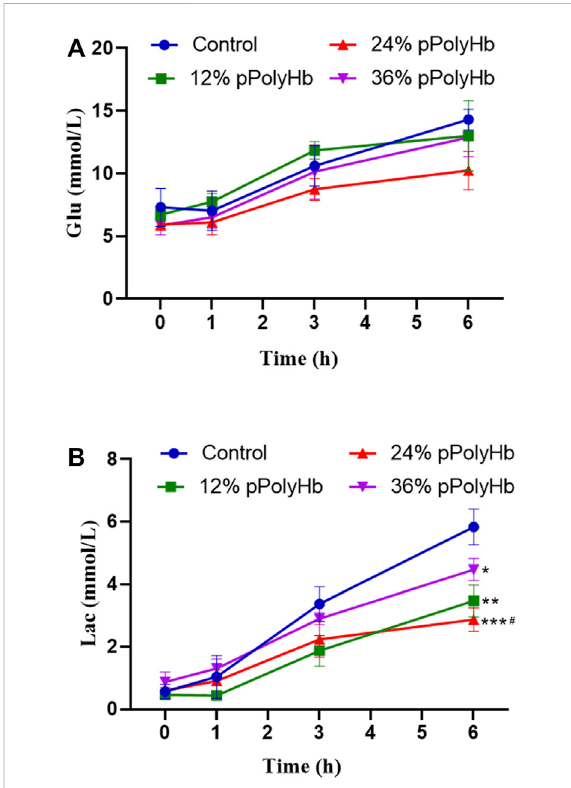
perfusion. The blood glucose levels in all four perfusion groups rose as perfusion duration was extended, however the 24% pPolyHb group ’ s perfusion group ’ s blood glucose increase trendwasthelowest (B) Theamount oflacticacid created byeach group during perfusion, with the control group producing the highest, the 36% pPolyHb group coming in second, and the 24% pPolyHb group coming in last (Note: * stands for comparison with the control group, # stands for comparison with 36%